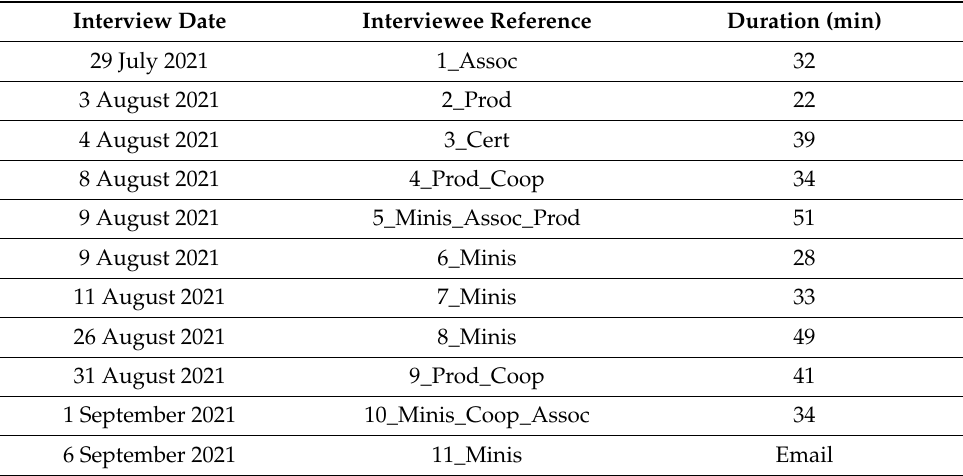
Table 2. List of conducted